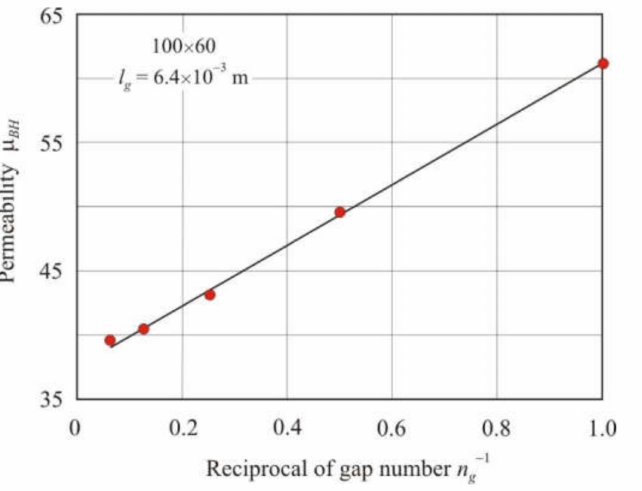
Figure 6. Dependence of the effective permeability µ BH on the reciprocal of air gap number n g − 1 in soft magnetic annuluses 100 × 60 mm with the total air gap length l g = 6.4 × 10 − 3 m. From Equation (22), it follows that with constant l , l g , and n g , core permeability is linearly related to S − 0.5 , where S is the cross-section area of the core. Figure 7 shows the dependence of the effective permeability µ BH on S − 0.5 in annular cores with two air